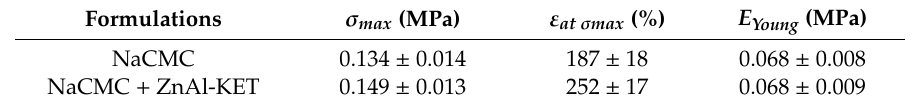
Figure 7. Stress–strain curves of NaCMC patch (NaCMC) and patch loaded with ZnAl-KET (NaCMC + ZnAl-KET). Table 2. Mechanical properties of NaCMC patch and patch loaded with